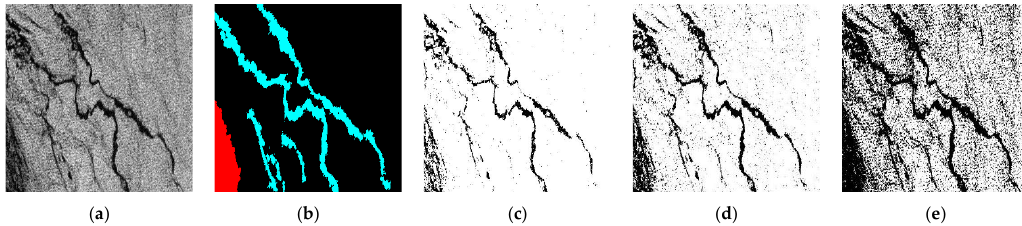
Figure 7. ( a ) The original image, ( b ) the label of the original image, ( c ) the segmentation result using a threshold of 40, ( d ) the segmentation result using a threshold of 75, and ( e ) the segmentation result using a threshold 125. The higher the threshold is set 75, the more speckle noise is retained. Setting the threshold to 75 not only removes most of the spots, but also has little impact on the oil spill area and oil spill like area (dark area).